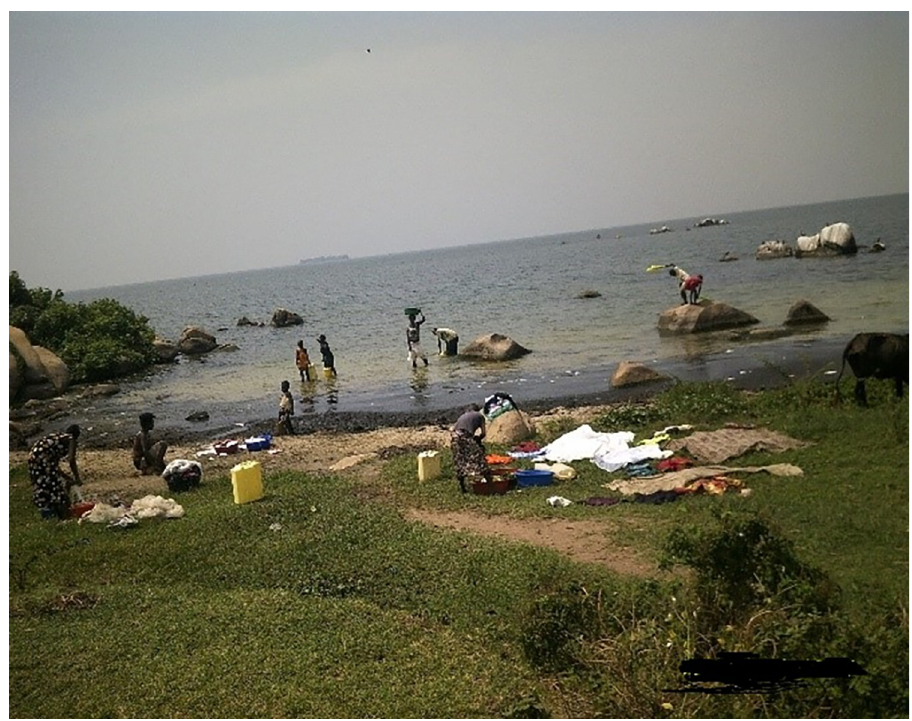
Fig 2. Common activities at the lake. Additional to the lake, in all three communities we observed taps with clean filtered lake water and boreholes drilled to provide naturally occurring water from the ground. However, these sources were not reliable as they were often locked, out of water, and/or faulty, especially in Bugoto and Musubi. Tap water was pumped from the lake by a solar pump which could not function during cloudy days and rainy periods. Even the functioning boreholes were often not used because people said the water was salty. In Bwondha there were several shallow wells with big queues. In Musubi, we saw people getting water from swamps and wells which were also used by animals to drink water.